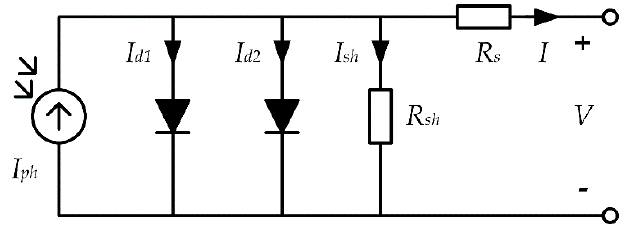
Figure 2. Equivalent circuit diagram for DDM.